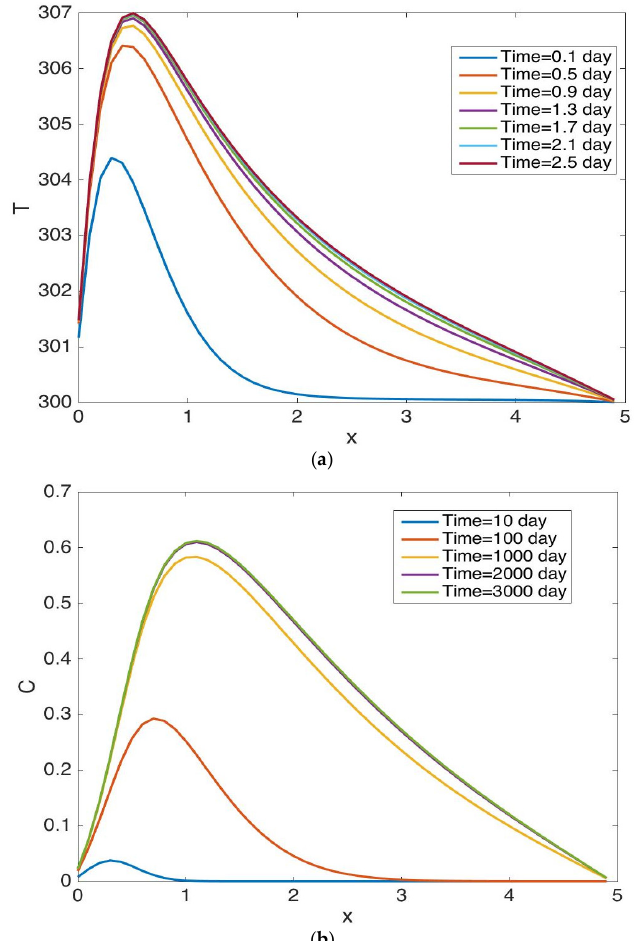
Figure. 10. Transient ( a ) temperature, and ( b ) concentration profiles against x -axis at y = 4, of Case